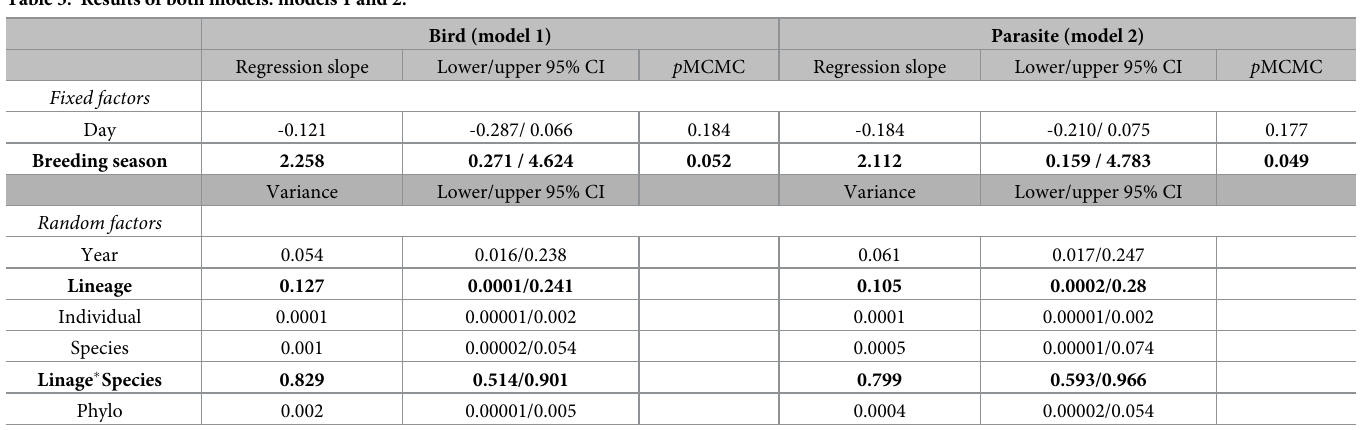
Table 3. Results of both models: models 1 and 2.